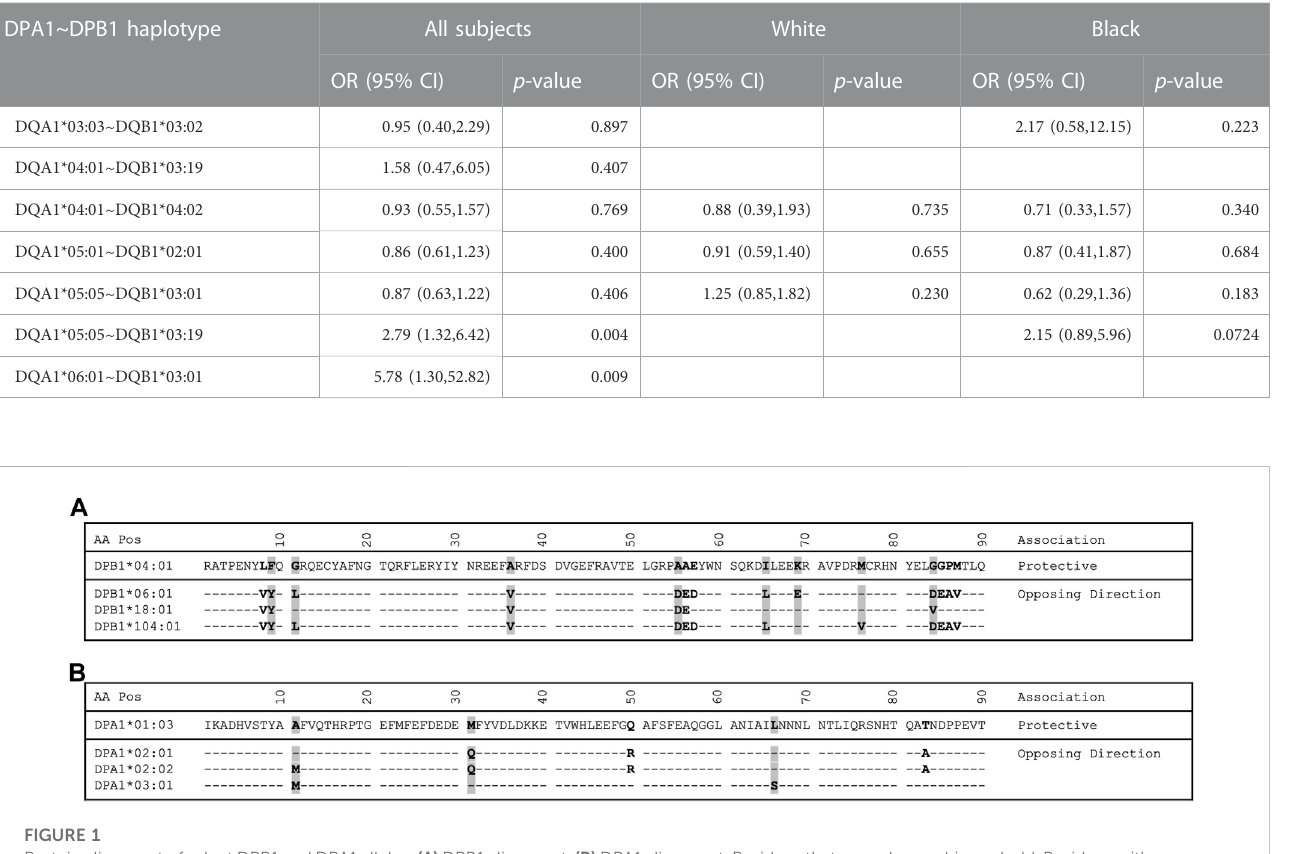
FIGURE 1 Proteinalignment ofselect DPB1andDPA1alleles. (A) DPB1alignment. (B) DPA1alignment.Residuesthatarepolymorphic arebold.Residueswithagray background indicate a pocket residue.